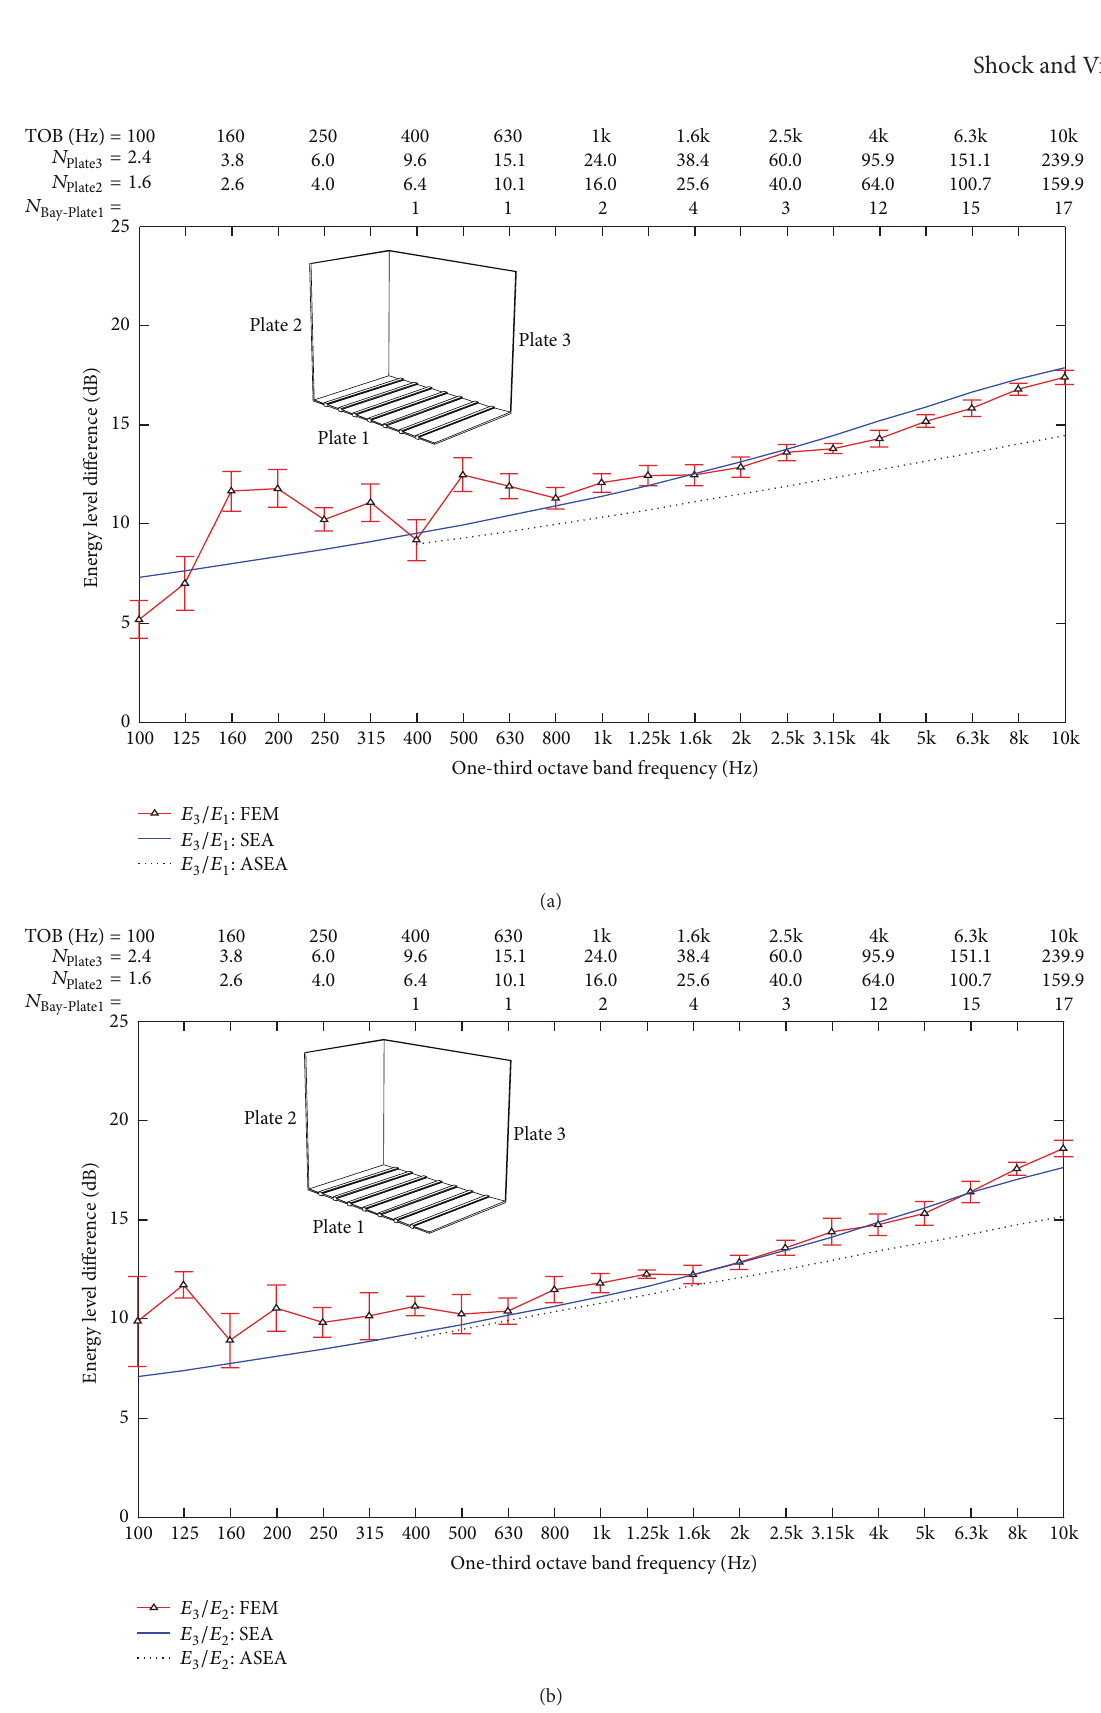
Figure 17: Three coupled plates. Excitation: Plate 3. Energy level differences between (a) the isotropic, homogeneous plate (Plate 3) and the periodic ribbed plate (Plate 1) and (b) the isotropic, homogeneous plate (Plate 3) and the isotropic, homogeneous plate (Plate